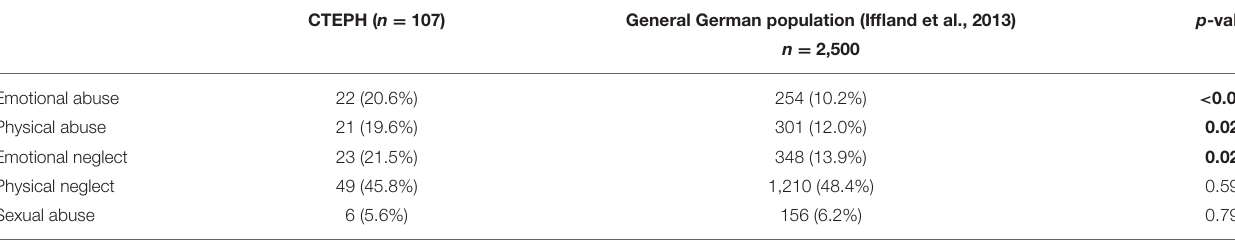
TABLE 2 | Prevalence of child maltreatment and its subtypes of CTEPH in comparison to data from the general German population. CTEPH ( n = 107) General German population (Iffland et al., 2013)